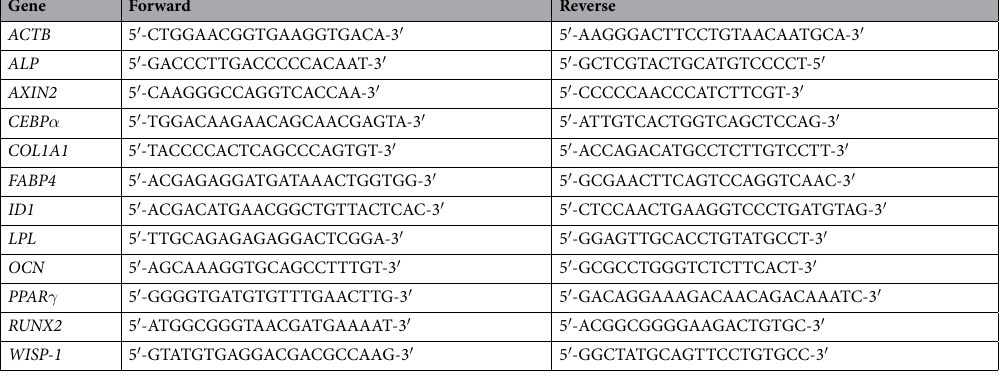
Table 3. Quantitative RT-PCR